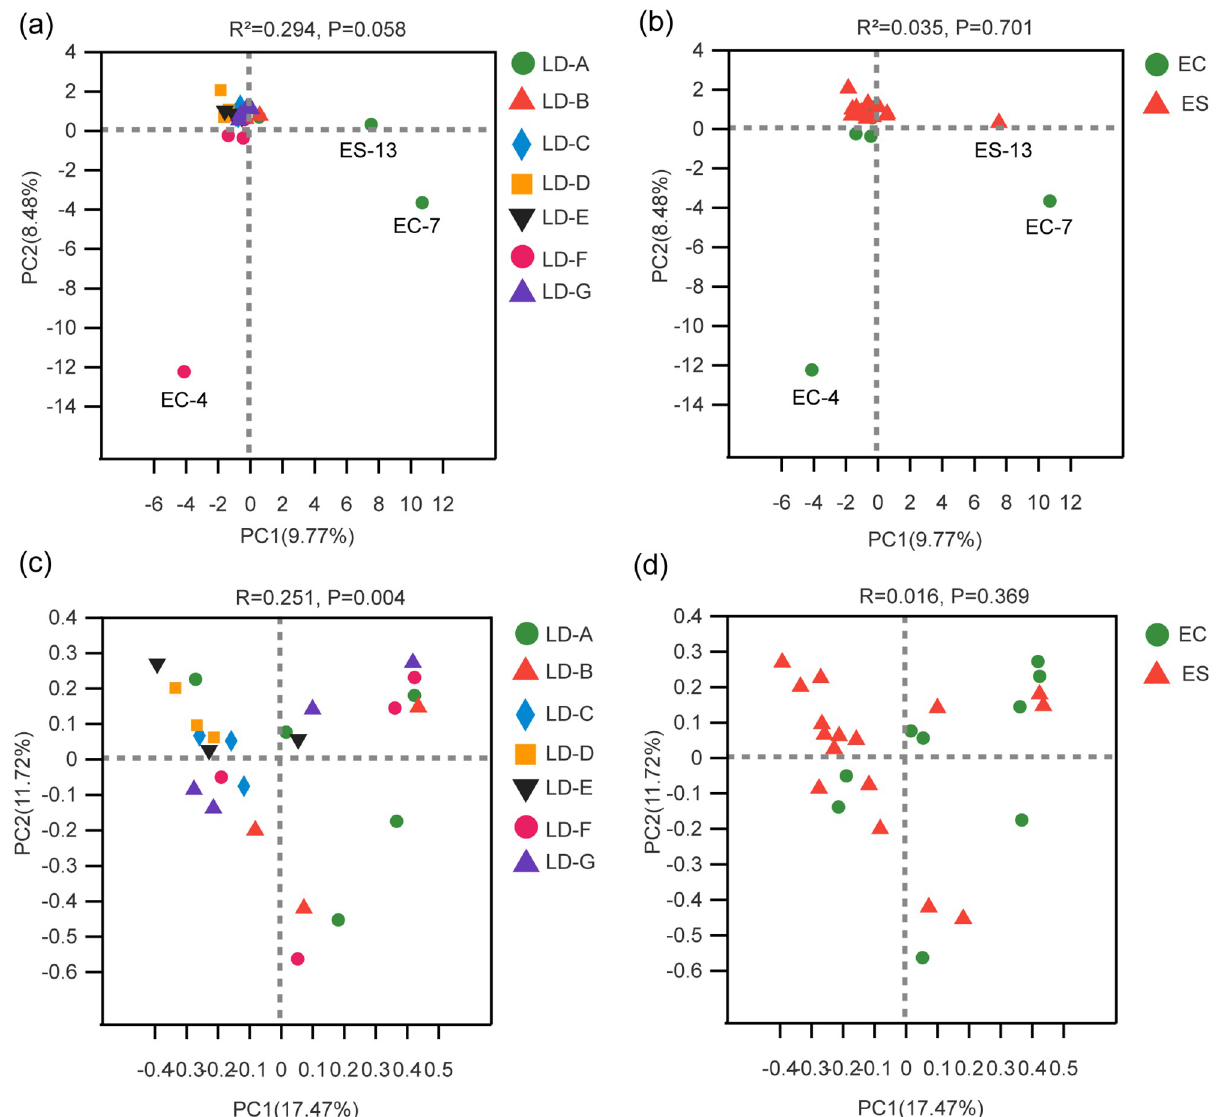
Fig 5. PCA and PCoA plots of food composition of zokor at genus level. a and b were PCA plots. a was the food PCA plot of the seven study areas, and b was the interspecific PCA plot of the two zokor species. c and d represent PCoA plots, c was the food PCoA plot of the seven study areas, and d was the interspecific PCoA plot of the two zokor